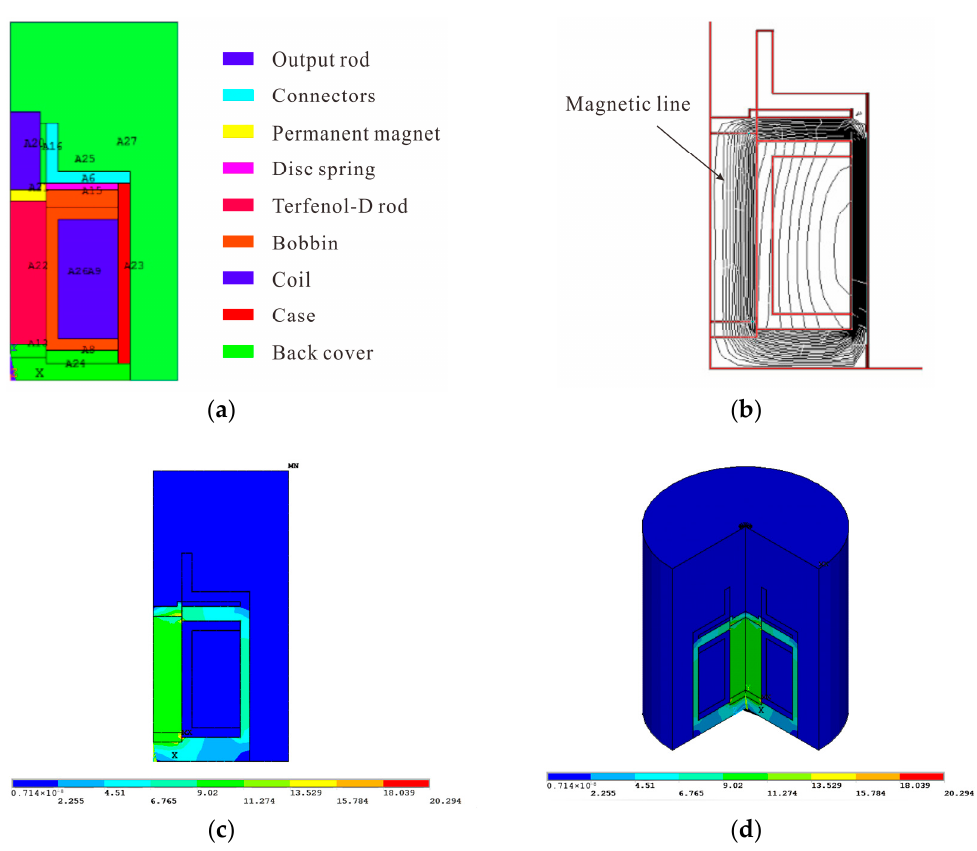
Figure 5. Finite Element Analysis of the Magnetic Field. ( a ) Transducer model; ( b ) Magnetic line of force distribution; ( c ) The magnetic flux density distribution; and, ( d ) The magnetic flux density distribution after expand.